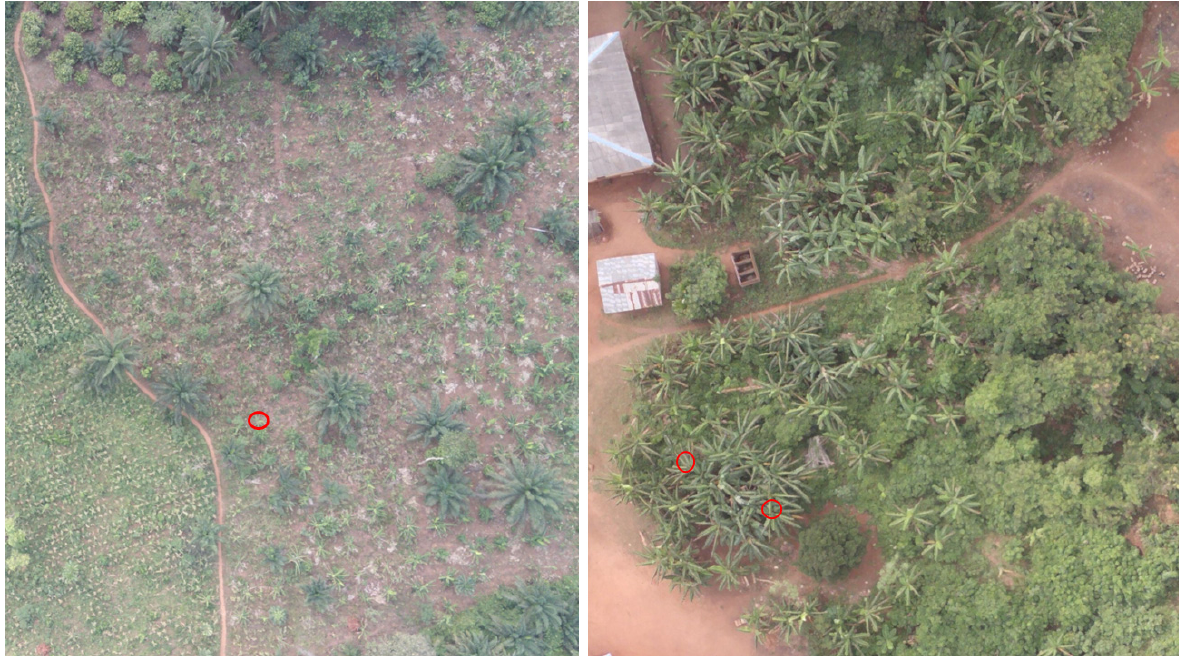
Figure 8. UAV RGB images of banana fields captured at an altitude of ~100 m during UAV flight missions in December 2020 in the Olokuta site in the Idologun region of Ogun State, Nigeria. The BBTV-infected plants were identified based on the ground survey in December 2020. The locations of BBTV-infected plants are shown with red